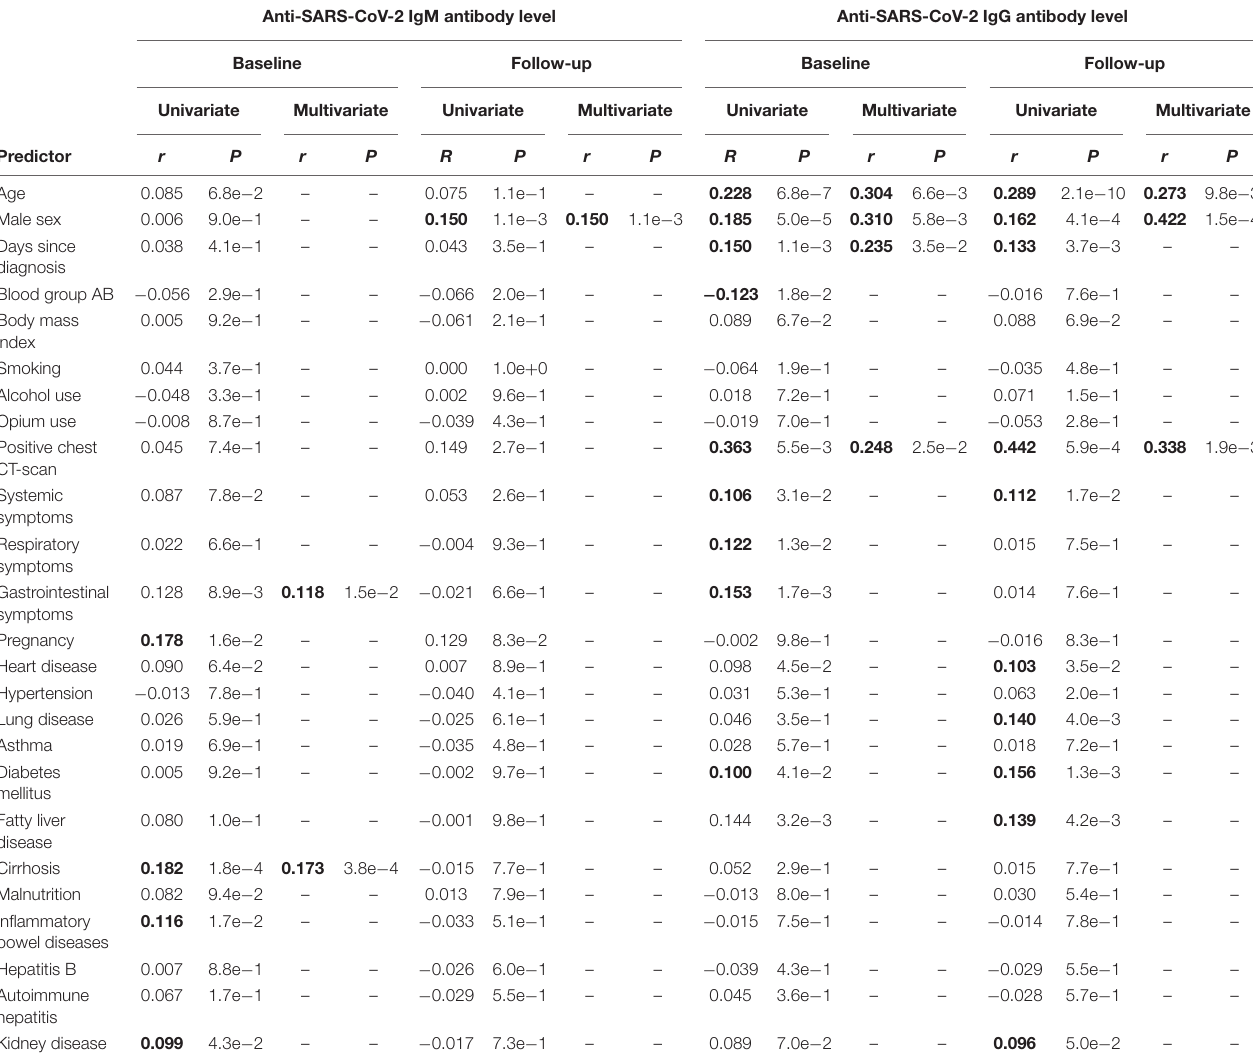
TABLE 2 | Correlations of the baseline characteristics, habits, pre-existing conditions, and baseline symptoms of COVID-19 patients with the baseline and 3-month follow-up (FU) anti-SARS-CoV-2 IgM and IgG levels. Anti-SARS-CoV-2 IgM antibody level Anti-SARS-CoV-2 IgG antibody level Baseline Follow-up Baseline Follow-up Univariate Multivariate Univariate Multivariate Univariate Multivariate Univariate